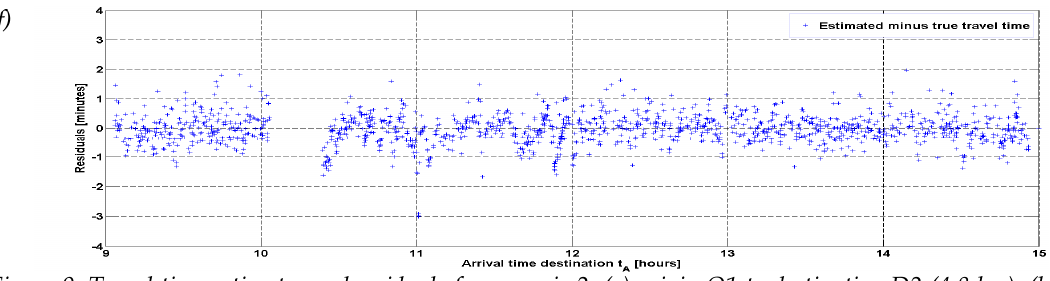
Figure 9. Travel time estimates and residuals for scenario 2: (a) origin O1 to destination D2 (4.8 km), (b) residual of estimates in Figure 9a, (c) origin O1 to destination D4 (9.3 km), (d) residuals of estimates in Figure 9c, (e) origin O1 to destination D6 (12.8 km), (f) residuals of estimates in Figure 9e. In Figures 9a, 9c, and 9e the red crosses indicate true travel times of individual vehicles and the black line represents the estimated travel times as a function of the downstream arrival time. In Figures 9b, 9d, and 9f the blue crosses indicate the residuals of the travel times, i.e. estimated minus true travel